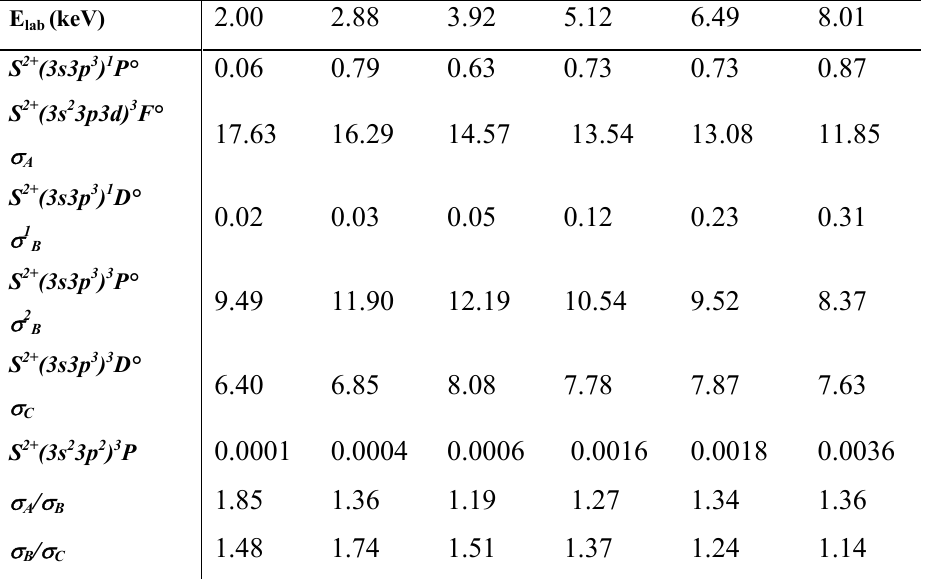
Figure 6: Calculated cross-sections on peak A, B, C (in 10 -16 cm 2 ) and comparison with experimental data [6]. X (experiment)/……….(calculation), σ (experiment)/………. (calculation), σ